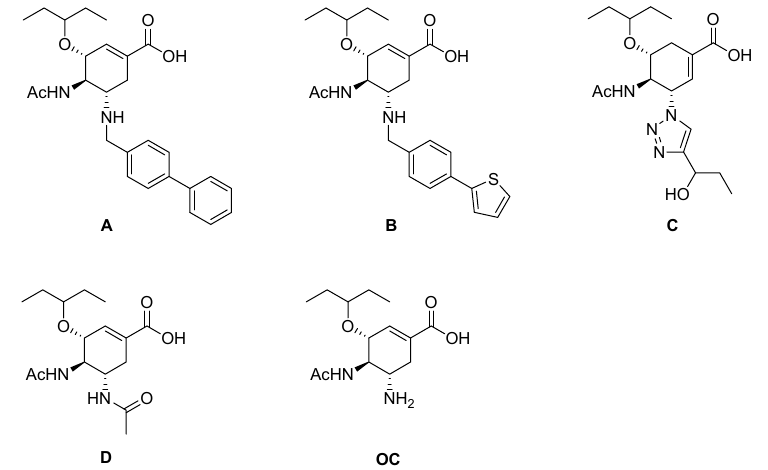
Figure 2. Chemical structures of compound A , B , C, and D , OC.